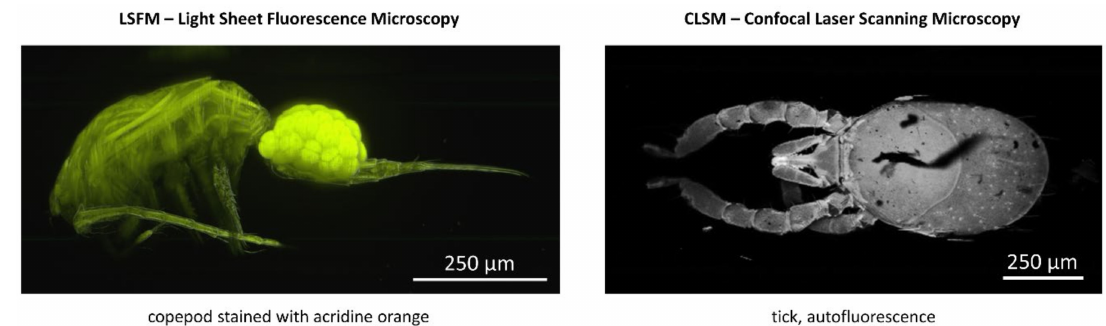
Figure 11. Fluorescence microscopy of small organisms: Copepod incubated with Acridine Orange, imaged with Light Sheet Fluorescence Microscopy (left), and a tick, autofluorescence, imaged with Confocal Laser Scanning Microscopy (right). Reproduced from Ref. [62] with